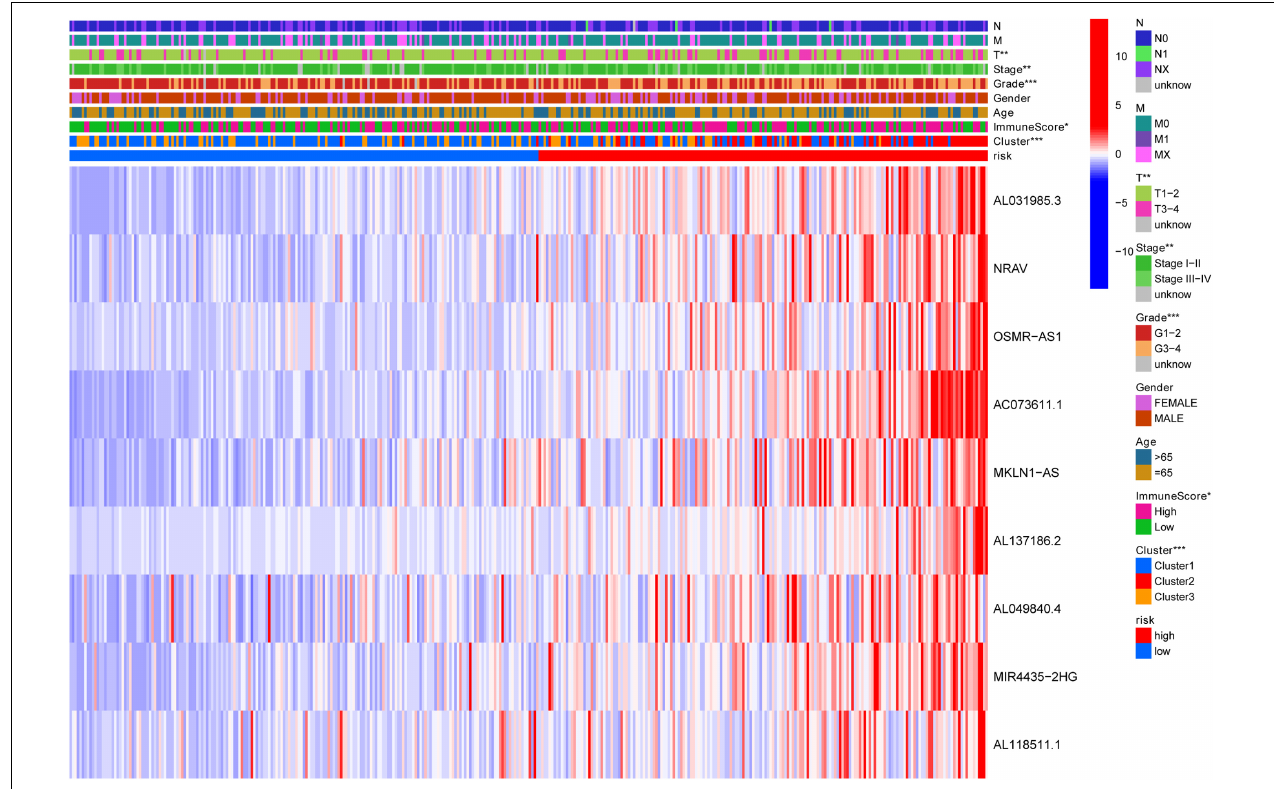
FIGURE 7 | Heatmap to show the connection between clinical pathology, clusters, and risk scores. The results indicated that the expression of the nine lncRNAs in the high-risk group was significantly higher than that in the low-risk group, and this trend was more obvious in cluster 2. N, lymph node; M, metastasis; T, tumor.